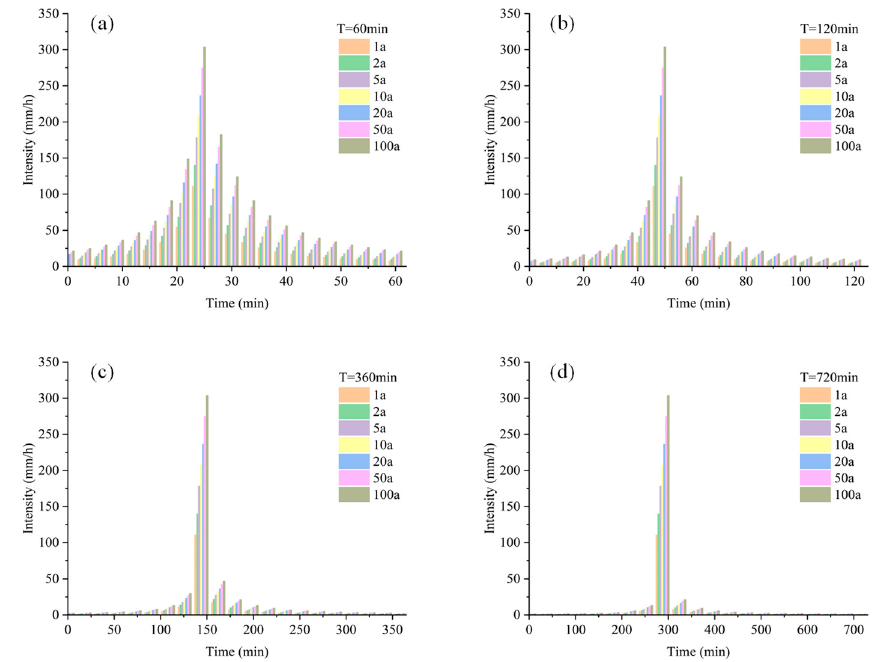
Figure 4. Synthetic hyetograph of four rainstorm patterns. The main difference among the four rainstorm patterns is the position of the rainfall duration; The rainfall duration is set as 60 min, 120 minutes, 360 min and 720 min, which are respectively named as Pattern 1 ( a ), Pattern 2 ( b ), Pattern 3 ( c ) and Pattern 4 ( d ).